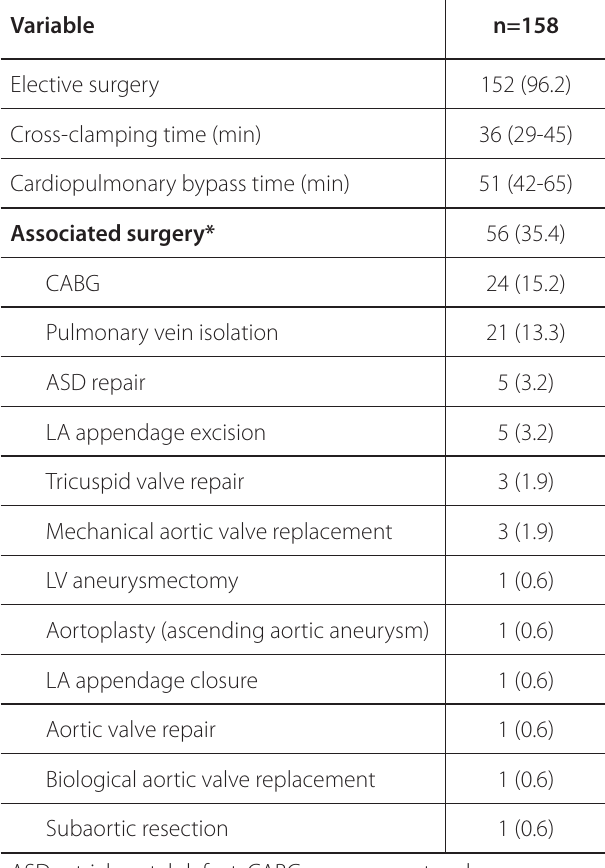
Table 2 . Surgical